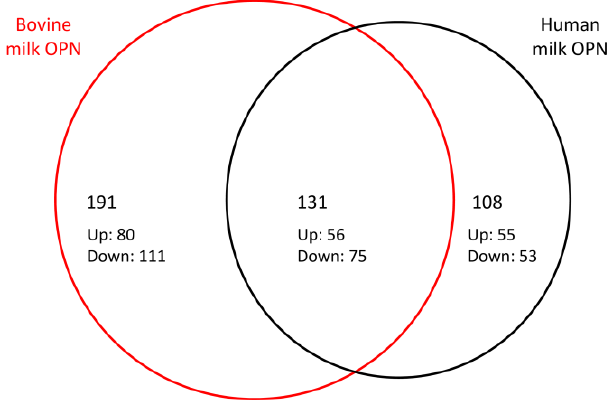
Figure 1. Volcano plots of the human milk OPN, bovine milk OPN, and a whey protein fraction with a high content of alpha-lactalbumin (ALA) treatments. Red (log 2 FoldChange >|-1|) and blue (log 2 FoldChange <|-1|) dots show the significant genes.